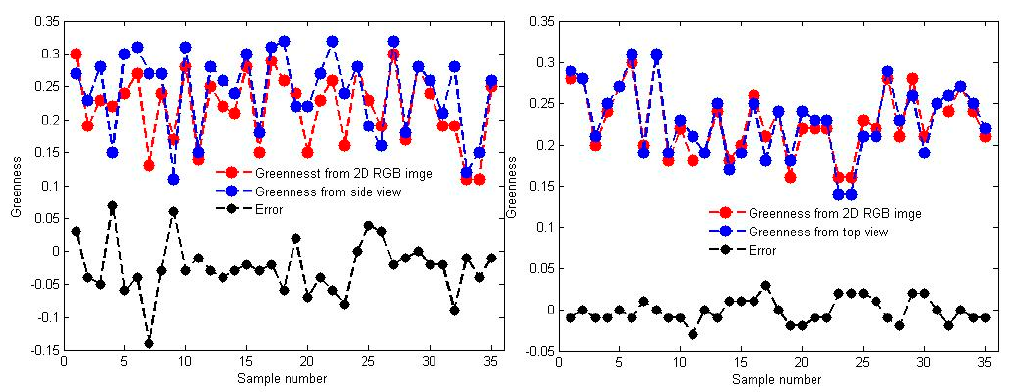
Figure 11. Greenness correlations between 3D measurements and manual measurements. ( left ) Side view ‐ based correlation; ( right ) top view ‐ based correlation.